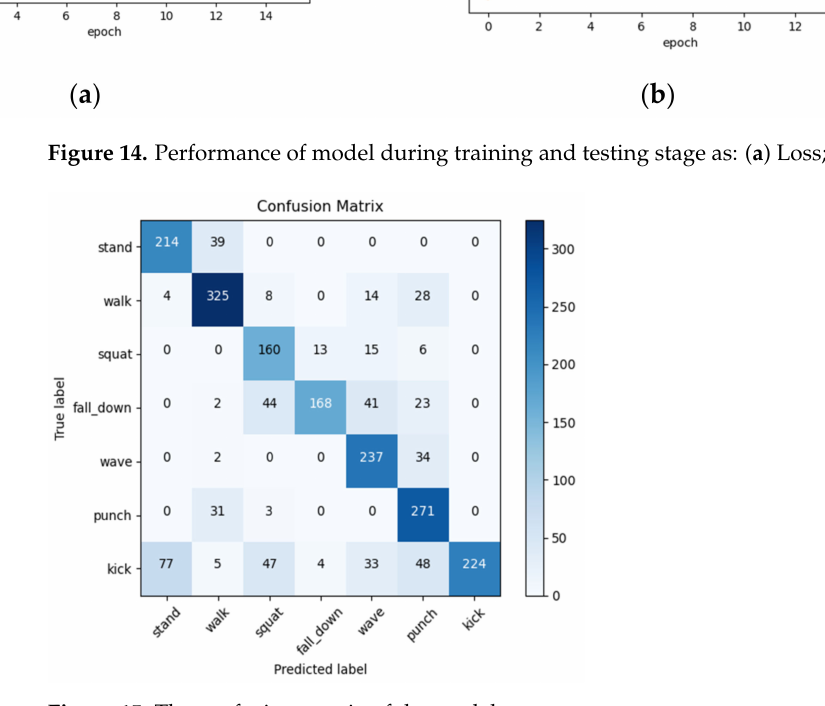
Figure 15. The confusion matrix of the model.